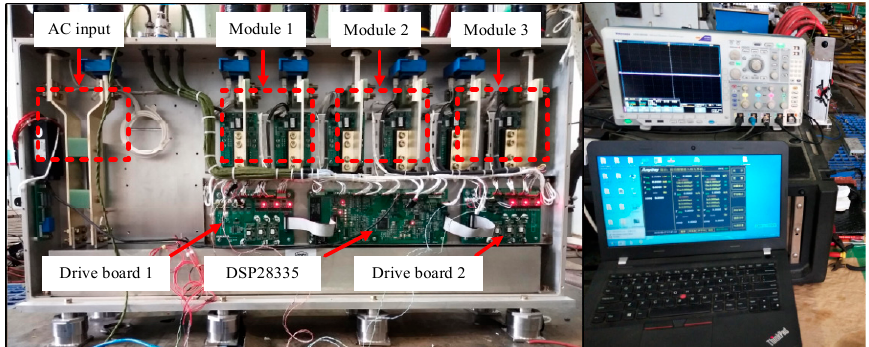
Figure 13. The experimental platform.